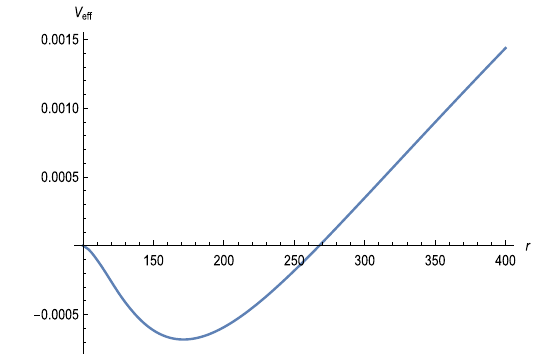
Fig. 2 Plotof V ef f ( r ) .Theparametersare M = 100, a = 80, Q = 60, q = 0 . 1, L = 5, and B = 0 . 0001. The horizon is located at r = 100. V ef f < 0 at the horizon. So the particle released somewhere outside the horizon, such as r = 200, can fall into the black hole